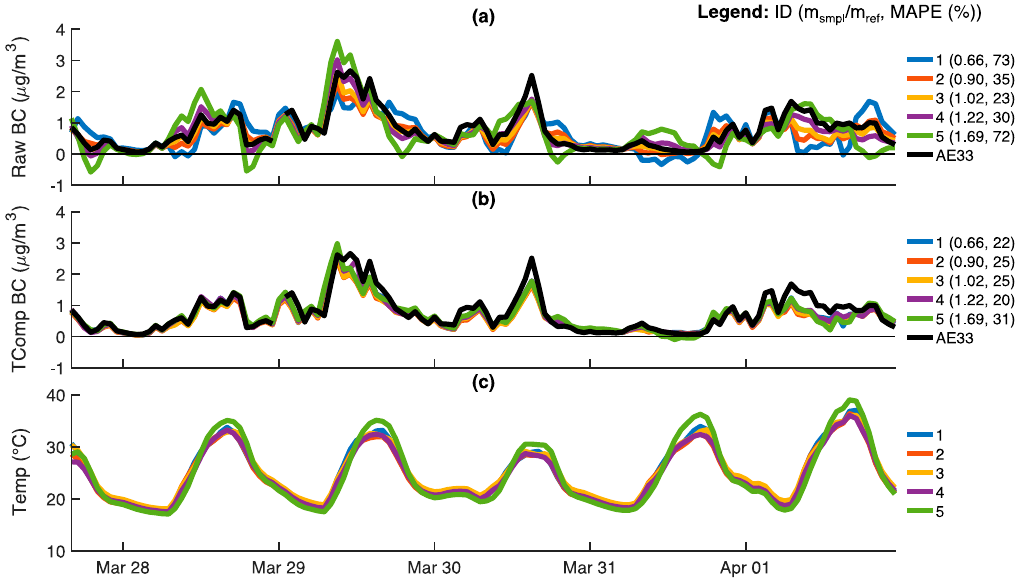
Figure 9. Five ABCD units operating outdoors atop a Bay Area Air Quality Management District near-roadway monitoring station: ( a ) Uncompensated black carbon (BC) concentrations; ( b ) Temperature-compensated BC concentrations; ( c ) Optical cell temperatures. Also shown are BC concentrations reported by a Magee Scientific AE33 housed inside the monitoring station (black). All data is provided on a 60-min time base. For each ABCD, the legend shows the slope ratio of the optical cell and mean absolute percent error (MAPE) of the BC measurements, the latter of which is based on deviations from BC concentrations reported by the AE33 reference instrument. The five ABCDs shown in this figure are different than those presented in Figure 7.